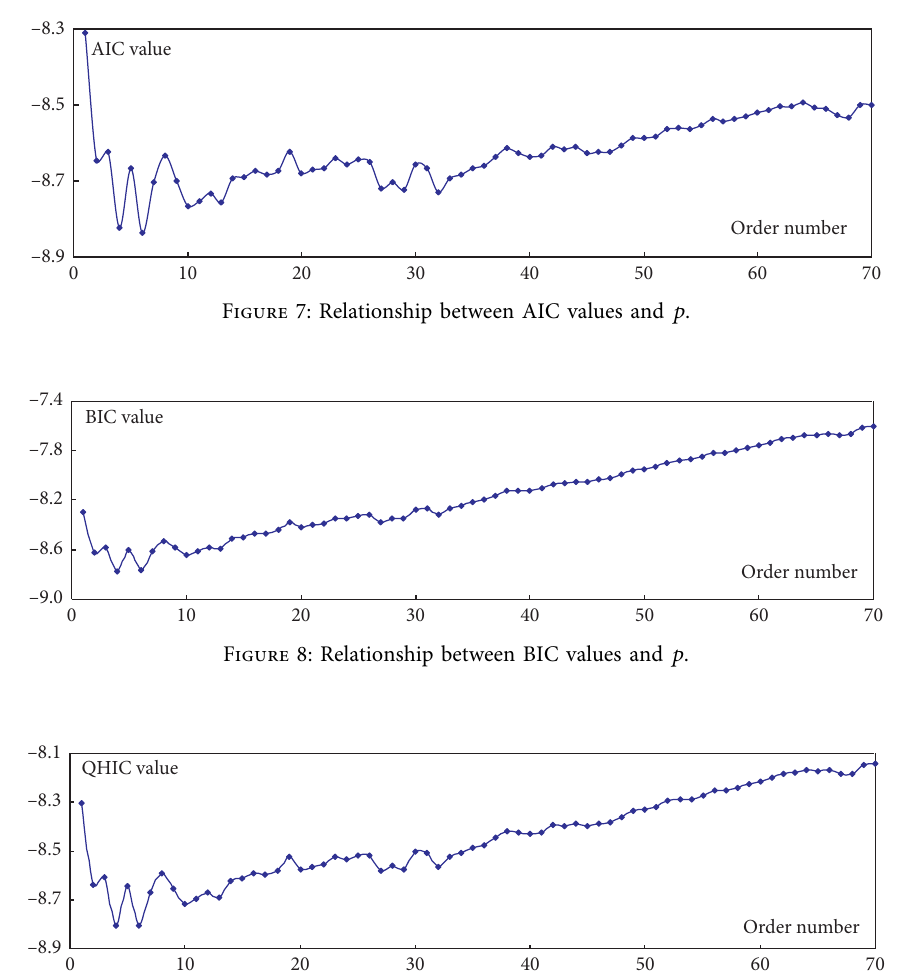
Figure 9: Relationship between QHIC values and p .